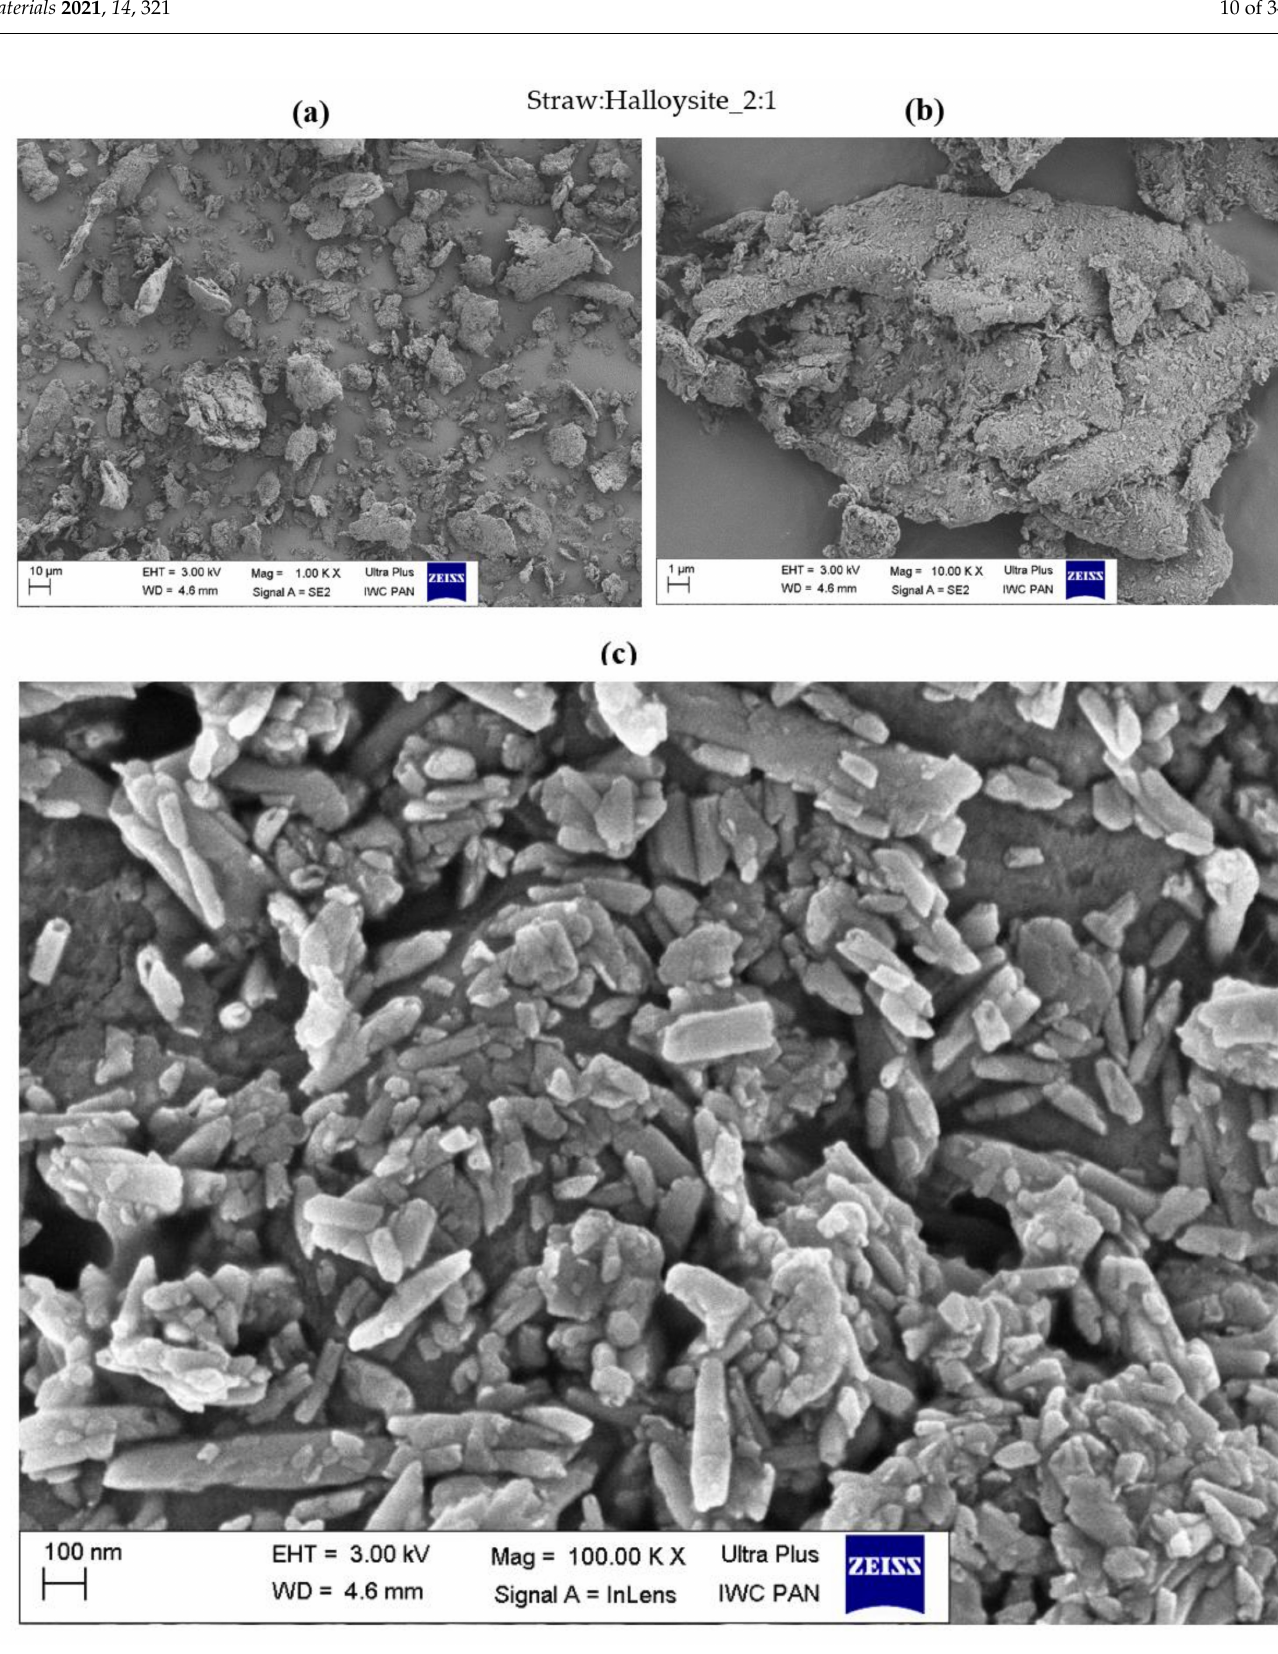
Figure 4. Microscopic images of straw fillers with the addition of halloysite nanotubes (2:1) at a magnification of ( a ) × 1.00 k, ( b ) × 10.000 k, ( c ) × 100.00 k (EHT is electron high tension; WD is working